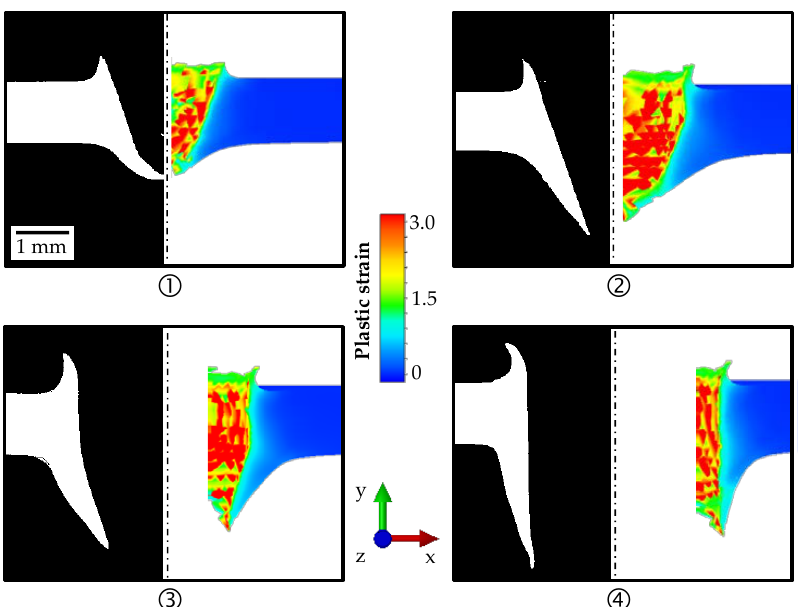
Figure 10. Comparison of the bushings for the experimental micrographs of the mounted separations and the 3D FE simulation at the states: entering ( 1 ) and breakthrough ( 2 ) of the conical part of the friction drill; and entering ( 3 ) and breakthrough ( 4 ) of the cylindrical part for HX220 at a 1.2 mm sheet thickness.